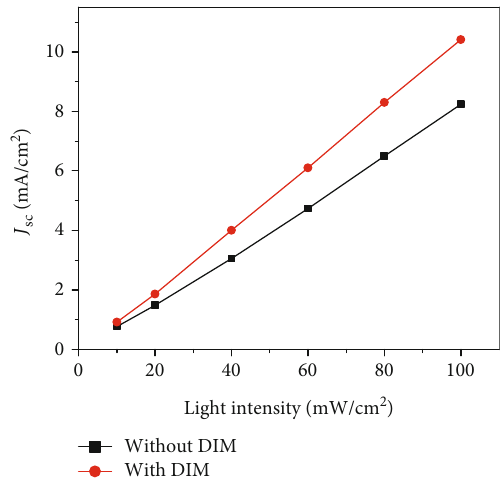
Figure 4: J sc versus light intensity for the PCDTBT:PC 71 BM solar cell processed without and with